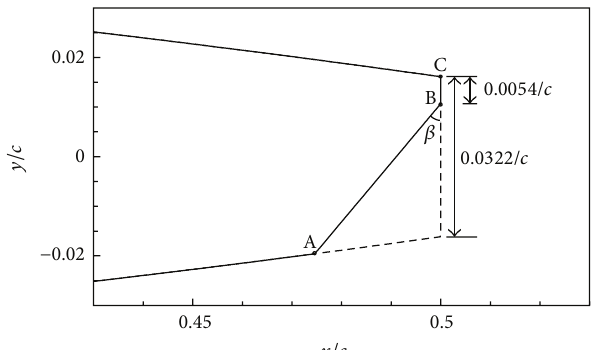
Figure 2: Trailing-edge shape. Note that the points A, B, and C indicate the knuckles of the chamfer and trailing-edge wedge, and the bevel angle is defined as 𝛽